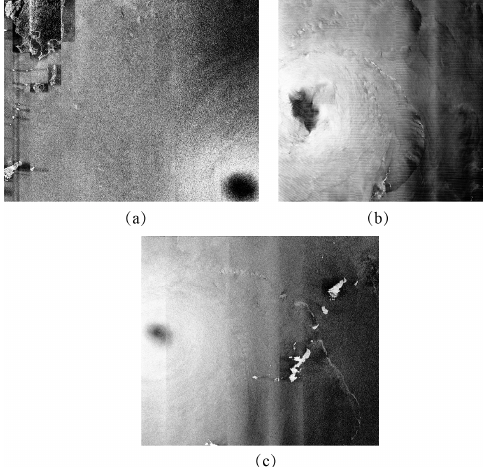
Figure 1. VH-polarization GF-3 SAR images taken during three typhoons. ( a ) The image from typhoon Noru acquired in Global Observation (GLO) mode on 2 August 2017 at 21:09 UTC. ( b ) The image from typhoon Doksuri acquired in Wide ScanSAR (WSC) mode on 13 September 2017 at 22:14 UTC. ( c ) The image from typhoon Talim acquired in GLO mode on 14 September 2017 at 21:29 UTC. The Windsat polarimetric radiometer was developed by the Naval Research Laboratory (NRL) and has the capability to measure all-weather winds from space with swath more than 350 km. A